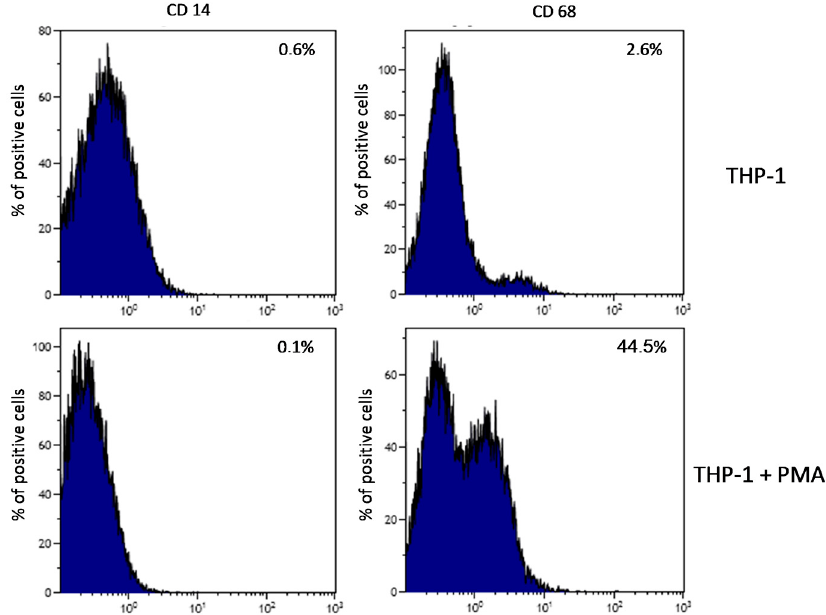
Figure 1. The effect of a plate on the activation of THP-1 monocytic cells. THP-1 monocytic cells were incubated in the presence of a plate without PMA (upper quadrants) and treated with PMA (lower quadrants). Expression was determined by flow cytometry. CD68 expression (marker for macrophage differentiation) increased after 48 h treatment with PMA (200 nM) as compared to non-treated cells. Expression of CD14 (marker for monocyte differentiation) did not change. Experiments were conducted as six separate assays, each assay in three replicates, ( n =